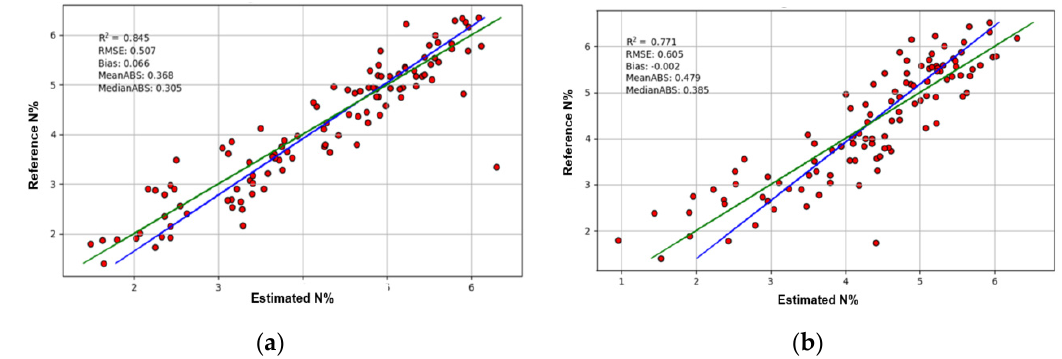
Figure 3. The first ‐ fold validation results of the PLSR models. The red dots are the results of validation. The green line is the ideal regression line and the blue line is the real regression line. ( a ) The first ‐ fold validation result of the model of the original FULL range data of the ASD FieldSpec 3 spectrometer; ( b ) The first ‐ fold validation result of the model of the original FULL range data of the FX10 and SWIR cameras in the phenotyping platform.